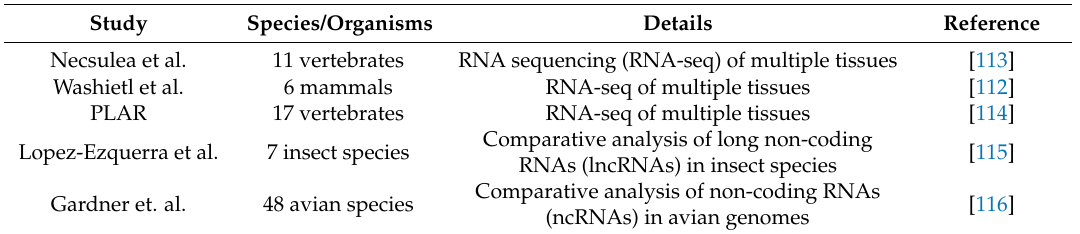
Table 5. Studies looking at lncRNA